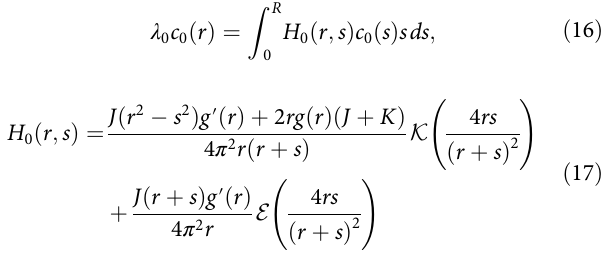
Fig. 6 Order parameters. Asymptotic behavior of the order parameter S : = max( S + , S − ) (black dots) and γ (red dots) for J = 0.5 and N = 800. Note the bifurcation of S from at K ≈ − 0.53 near the approximation (18) K c = − 1.2 J = − 0.6. Data were collected using Heun ’ s method for T = 1000 time units with stepsize dt = 0.01, of which the fi rst half were discarded as transients. Each data point represents the average of one hundred realizations. Swarmalators were initially placed in a box of length 2 uniformly at random for all values of K with a common seed, while their phases we drawn from [ − π , π